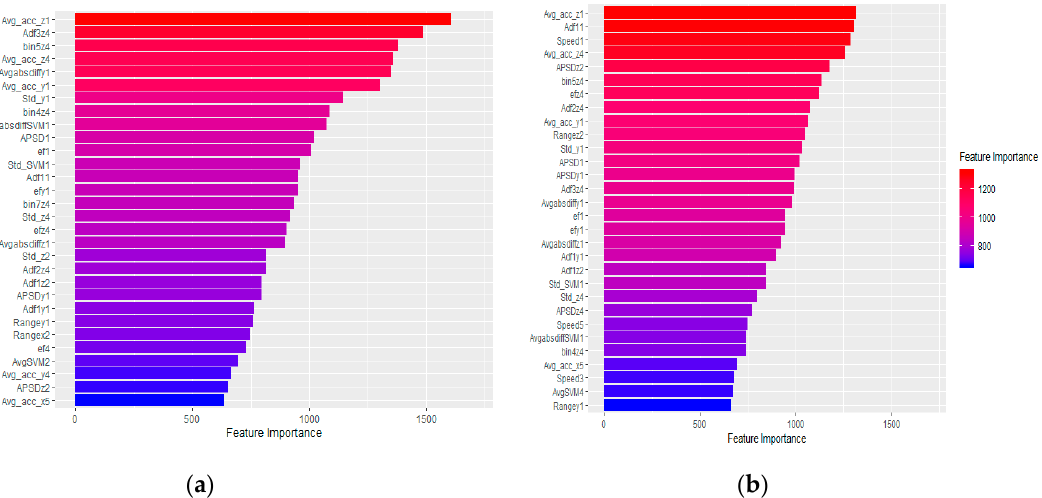
Figure A3. Top 30 important features of a participant’s general RF model (with the highest GPS contribution) trained with combined data (see the feature description in Table A3). ( a ) Accelerometer data only and ( b ) accelerometer and GPS data.